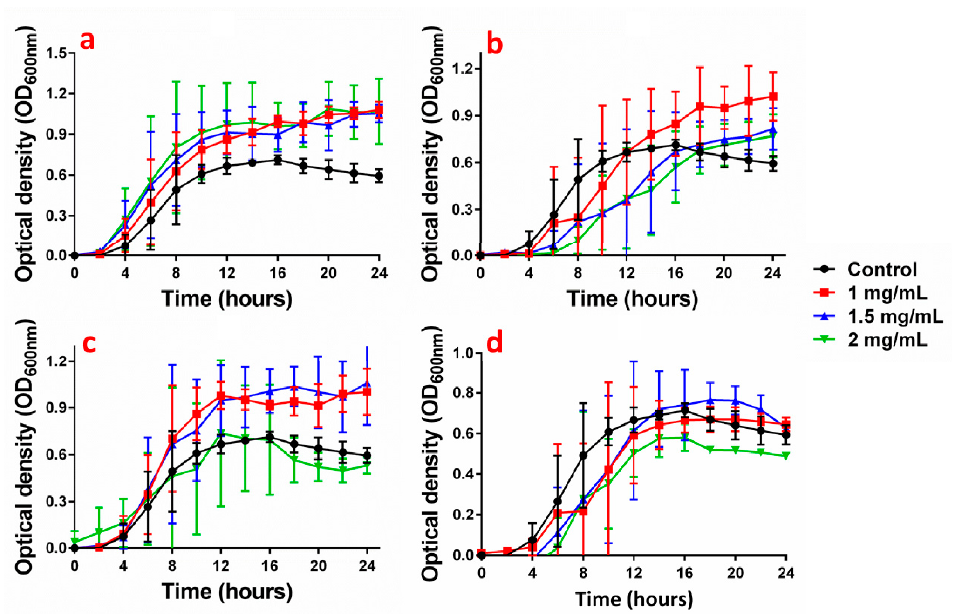
Figure 16. Growth curves of the nanocomposites D with the ratios ( 1 ) Ag ( a ), ( 2 ) ( b ), ( 3 ) ( c ), and ( 4 ) ( d ) at various concentrations against E. coli .